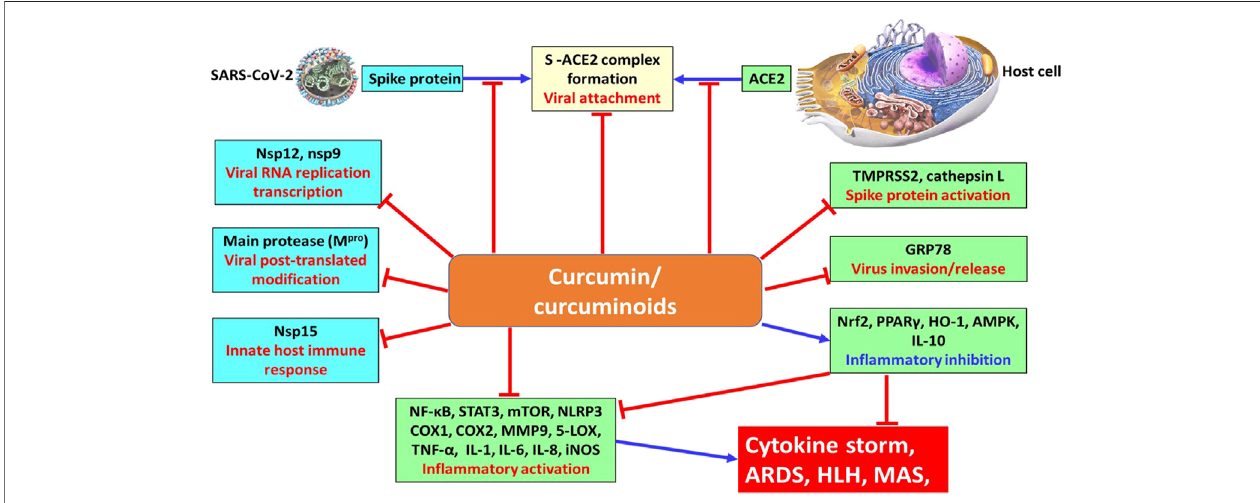
FIGURE 2 | Underlying mechanism of curcumin and curcuminoids on the viral protein and host cell proteins for combating the COVID-19 pandemic. stimulation; inhibition.